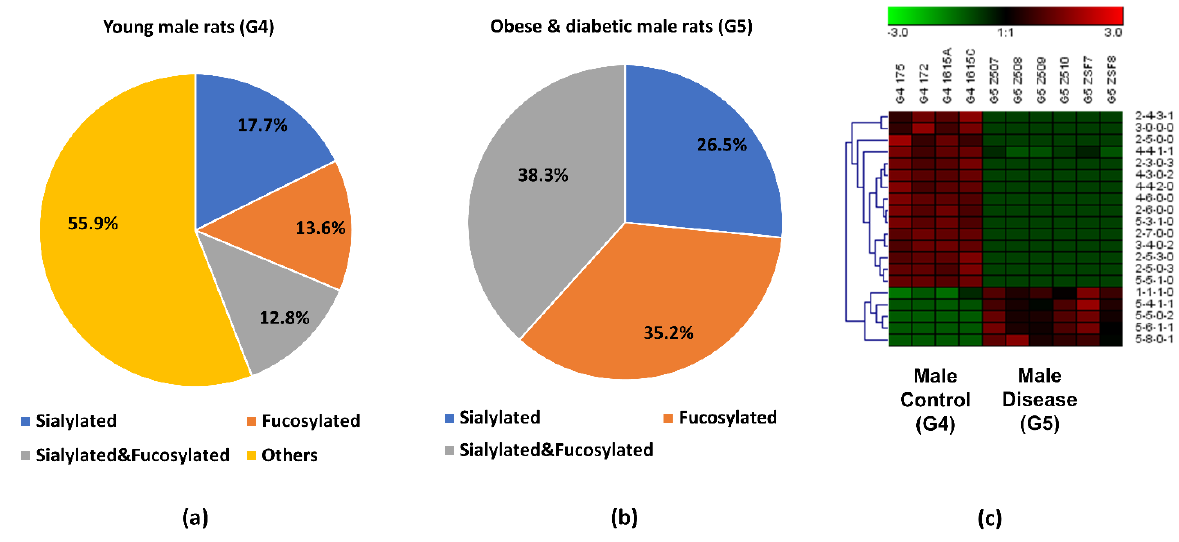
Figure 5. Distribution changes in the different O -glycan types from ( a ) the male control (G4) and ( b ) the obese and diabetic male (G5); ( c ) heatmap of 20 O -glycans that exhibited significant expression changes between G4 and G5. In the heatmap, each row represents an individual significant O -glycan. A red cell denotes a high relative abundance, while green represents a low relative abundance of the O -glycan.